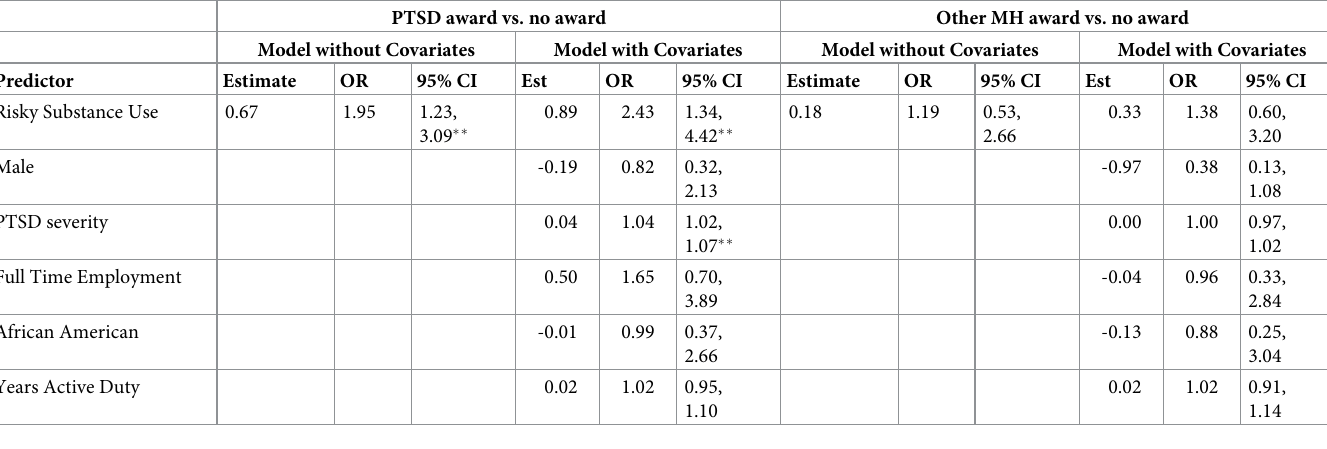
Table 3. Multinomial logistic regression of compensation award for PTSD or any mental health condition vs. no